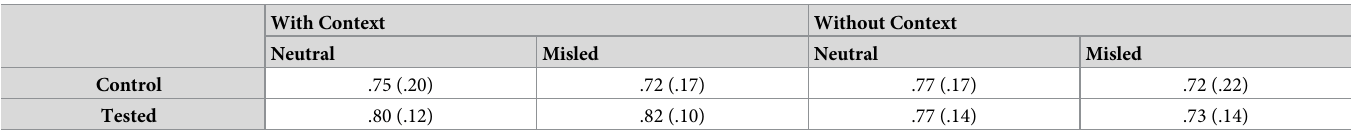
Table 4. Mean probabilities and standard deviations of correct responses on the recall test during the misinformation presentation phase of Experiment 2. With